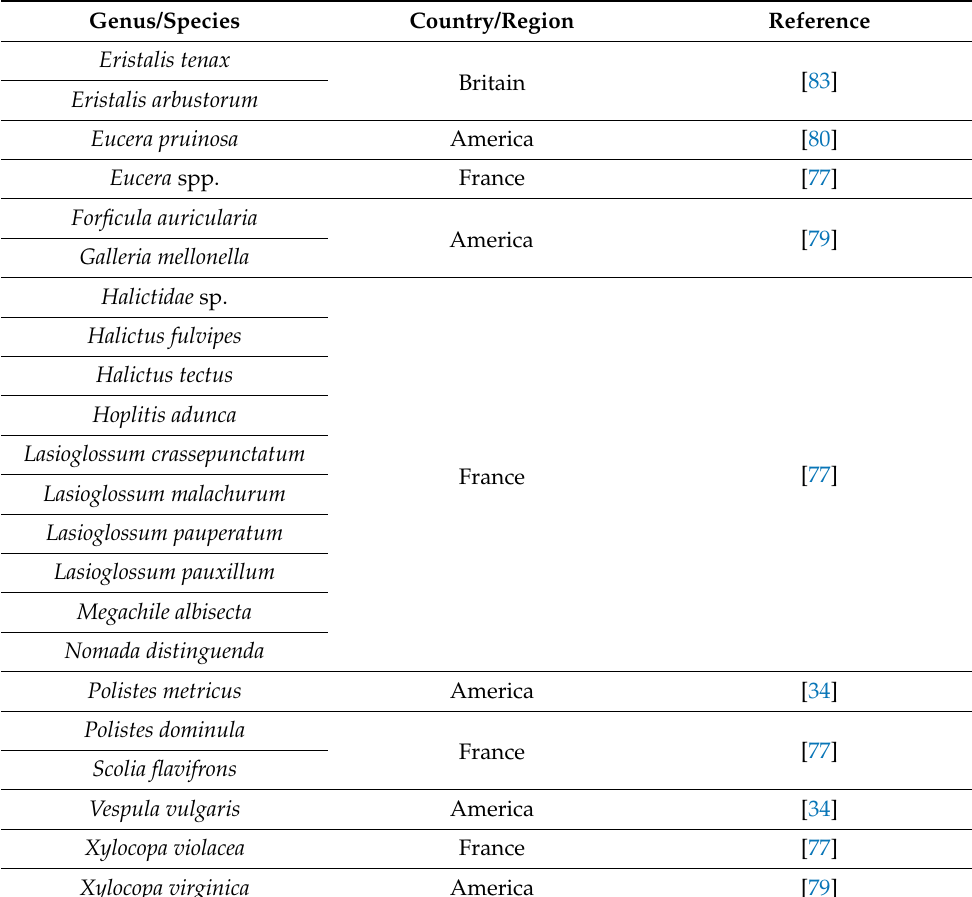
Table 1. Cont. Genus/Species